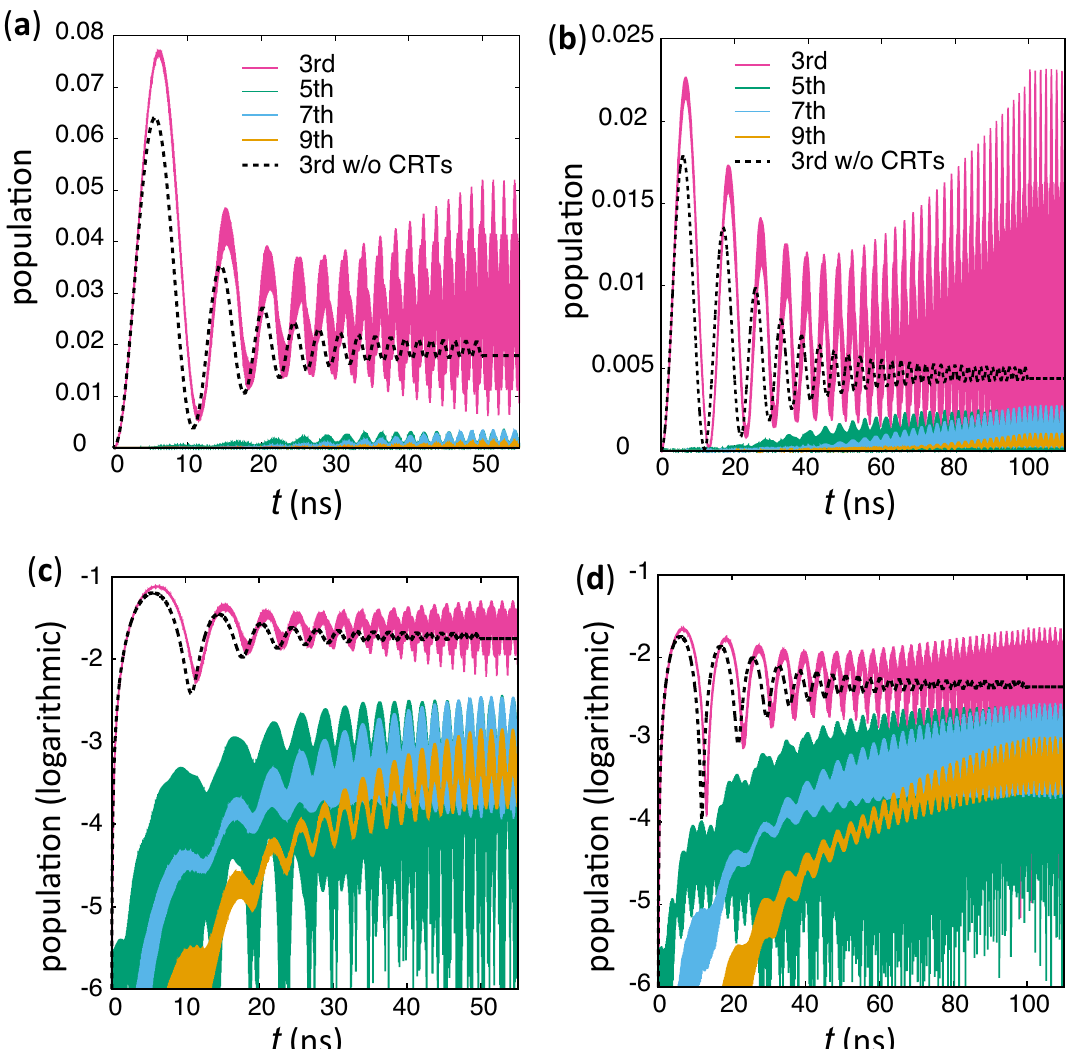
Figure 3. Time dependence of the population of the third, fifth, seventh and the nineth highest levels during 50 ns ( a ) and 100 ns ( b ). The population of the second, fourth, sixth, the cat-state creation for T = vanishing because of the difference of the parity. The dotted curves represent the population of the third highest level in the dynamics without NROTs. The used parameters are the same as Fig. 2a. ( c ) and ( d ) are the same things as ( a ) and ( b ), respectively, but with the vertical axis in the logarithmic